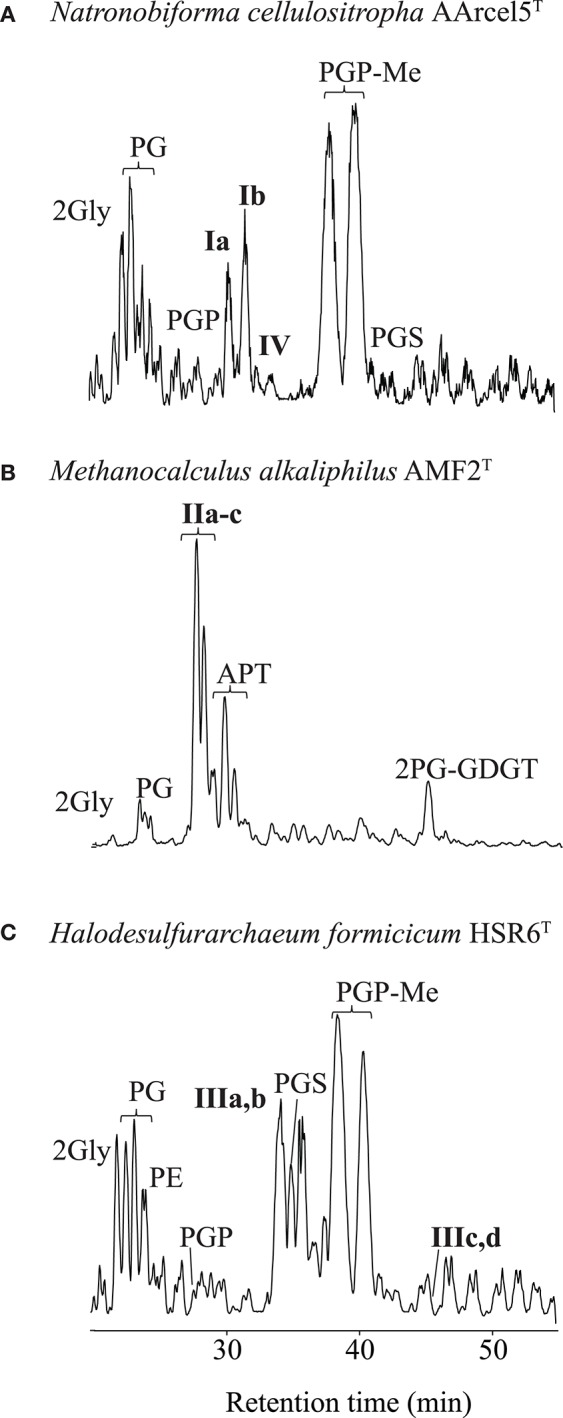
Partial base peak chromatogram (Gaussian smoothed) of the HPLC-ITMS analysis of IPLs in three strains of haloarchaea: (A) Natronobiforma cellulositropha AArcel5, (B) Methanocalculus alkaliphilius AMF2T, (C) Halodesulfurarchaeum formicicum HSR6T. For abbreviations of IPL names see text.